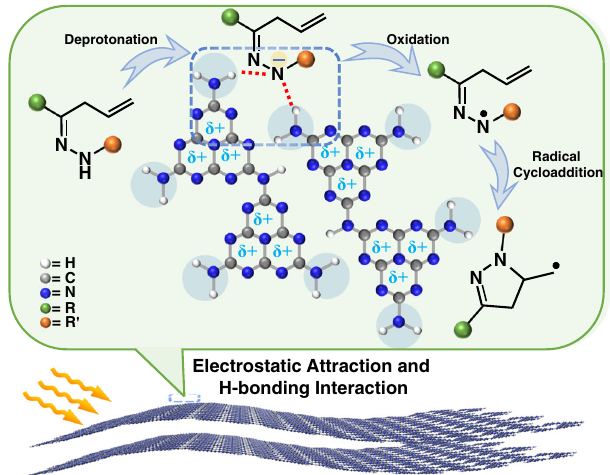
Fig. 1 | Interface assisted catalytic cyclization of nitrogen-centered radicals over carbon nitride. Photocatalytic oxidative cyclization of hydrazones through promoting substrate/catalyst